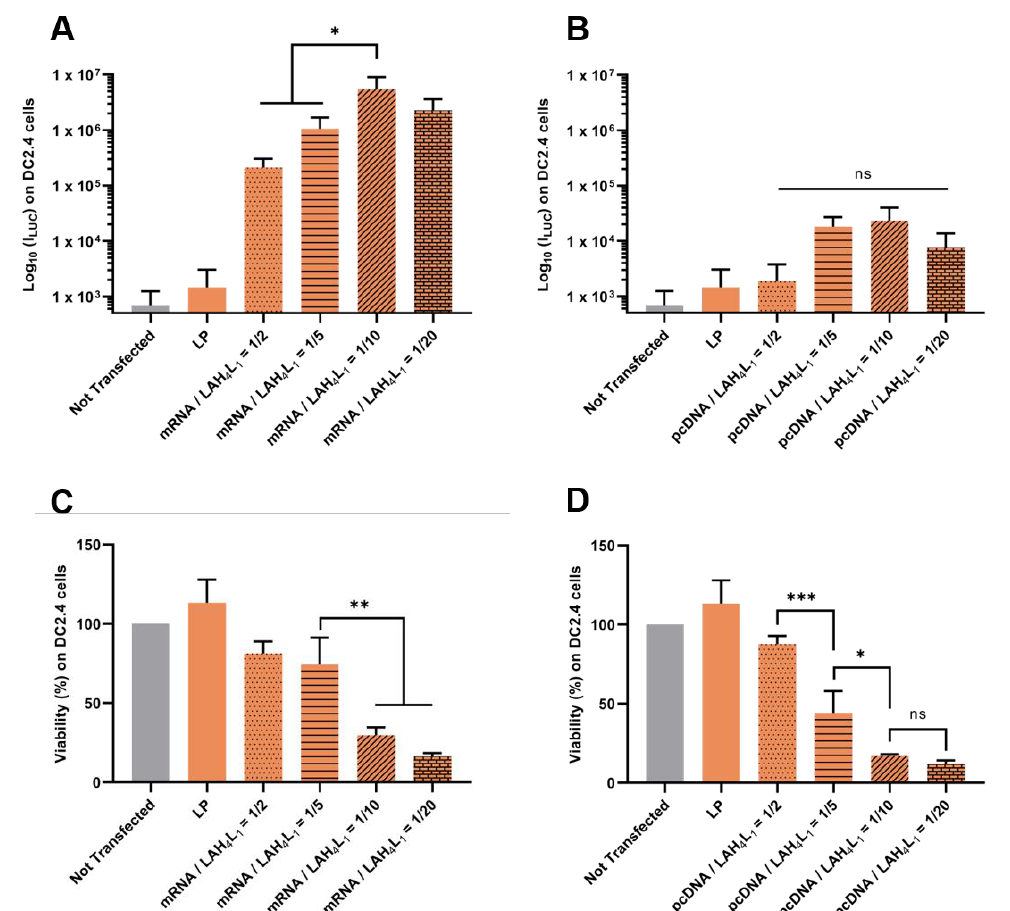
Figure 7. Evaluation of the influence of nucleic acids/ LAH4-L1 w / w ratio during pLbL formulation. Analysis of (top) the transfection efficiency by measuring luminescence intensity (Bright-Glo luciferase assay) and (bottom) cell viability (PrestoBlue assay) obtained after transfection of 90 ng eq. of either Fluc mRNA or luciferase-pcDNA3.1 formulated in LP using the pLbL strategy. Nucleic acids/LAH4-L1 w / w ratio ranged from 1:2 to 1:20. Transfection was performed both on HeLa ( A , C ) and DC 2.4 ( B , D ) cells. Lipofectamine 2000 TM was used as positive control. Data are presented as mean ± SD and statistically analyzed using one-way ANOVA followed by Tukey’s multiple comparison test (ns: p > 0.01, *: p < 0.01, **: p < 0.001 and ***: p < 0.0001).